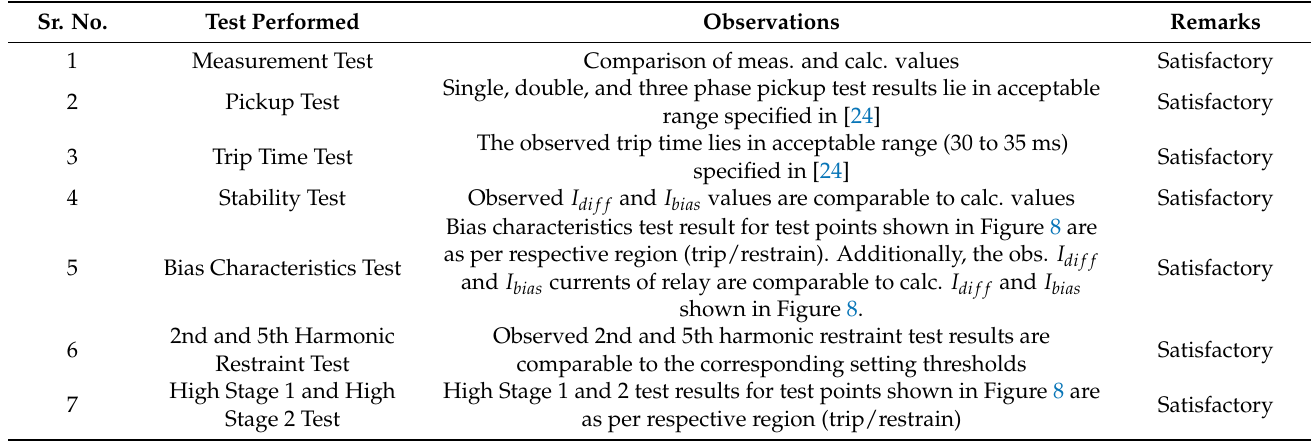
Table 13. Summarized results of differential relay